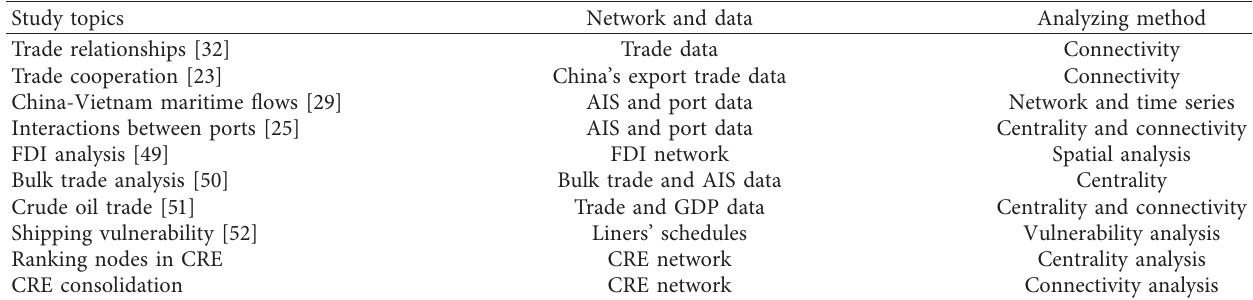
Table 3: BRI-related studies using network analyzing methods.